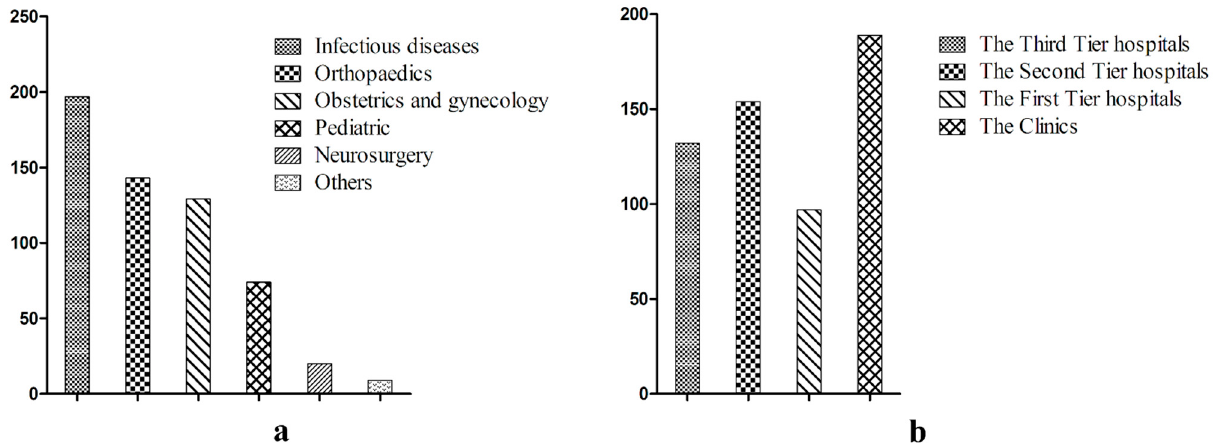
Figure 1. The general characteristics of the 572 cases. Notes: ( a ) the disease distribution of the cases; ( b ) the medical institution distribution of the cases.